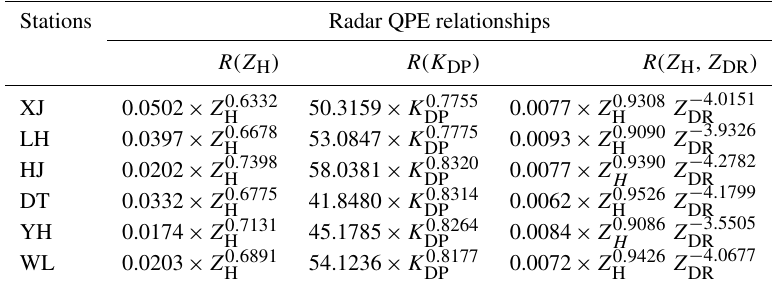
Figure 26. The scattergram of 6h rainfall estimates from R ( Z C 9 August 2019: (a) – (c) are, respectively, for results calculated using Eqs. (14a)–(14c). Table 3. Radar QPE relationships at six different meteorological stations.